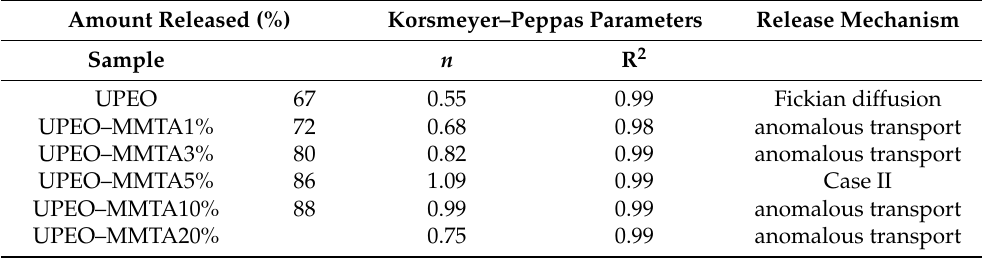
Table 1. Amount released of DCF, the Korsmeyer–Peppas parameters, and release mechanism of